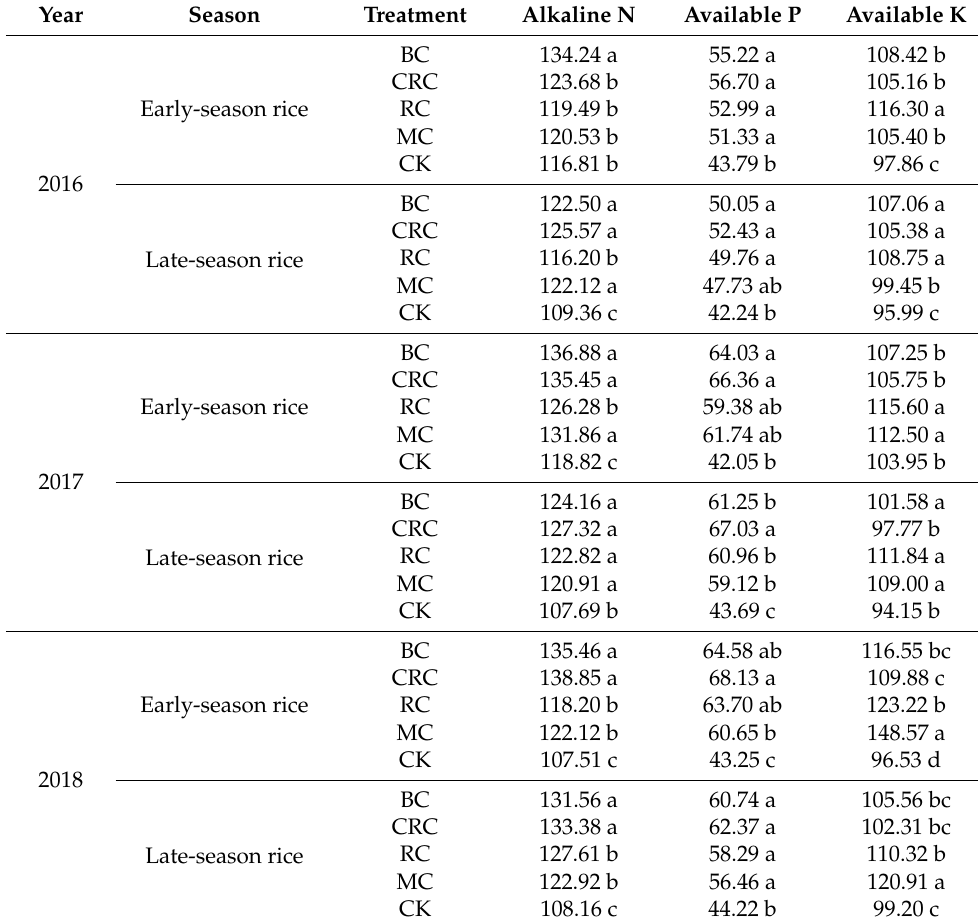
Table 4. Soil alkaline N, available P, and available K under different organic material treat- ments (mg kg − 1